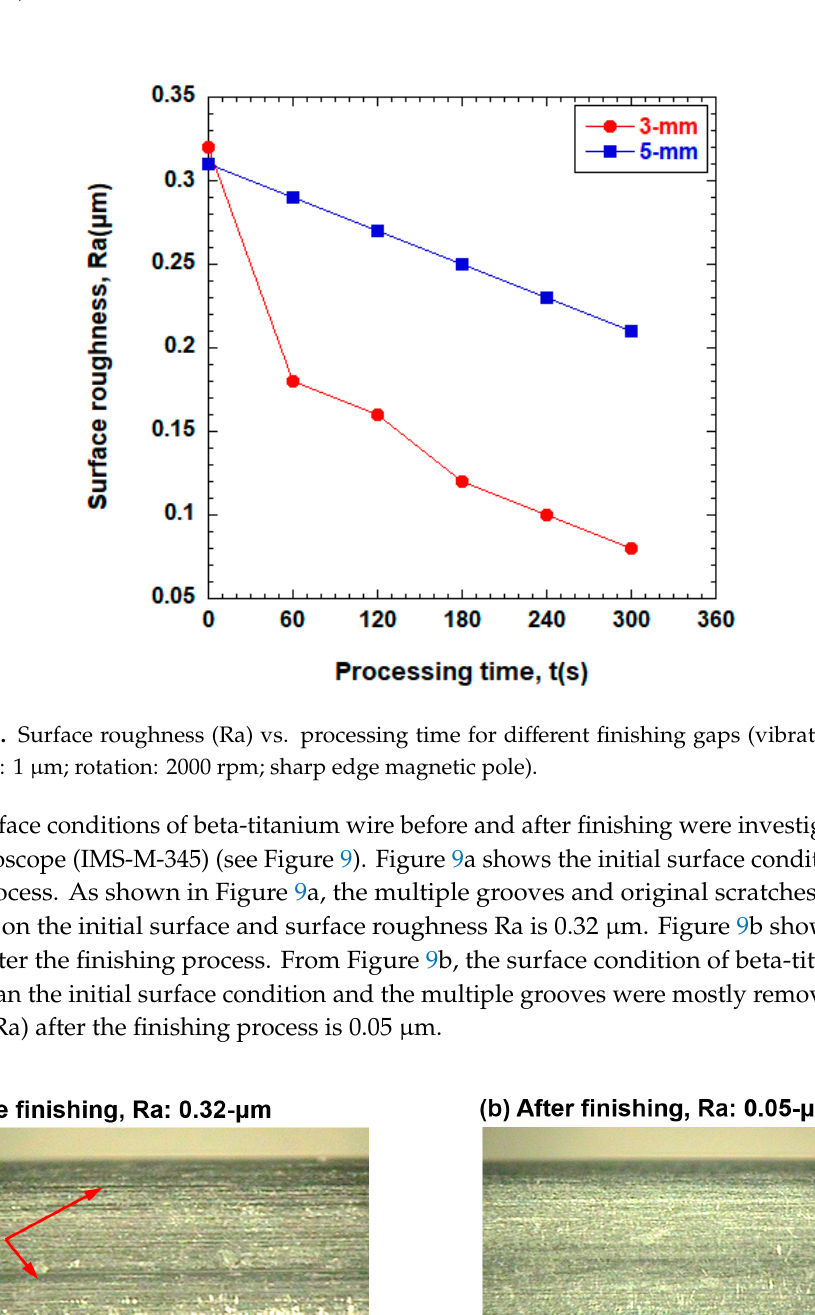
Figure 7. Magnetic flux density (T) vs. distance for different finishing gaps.